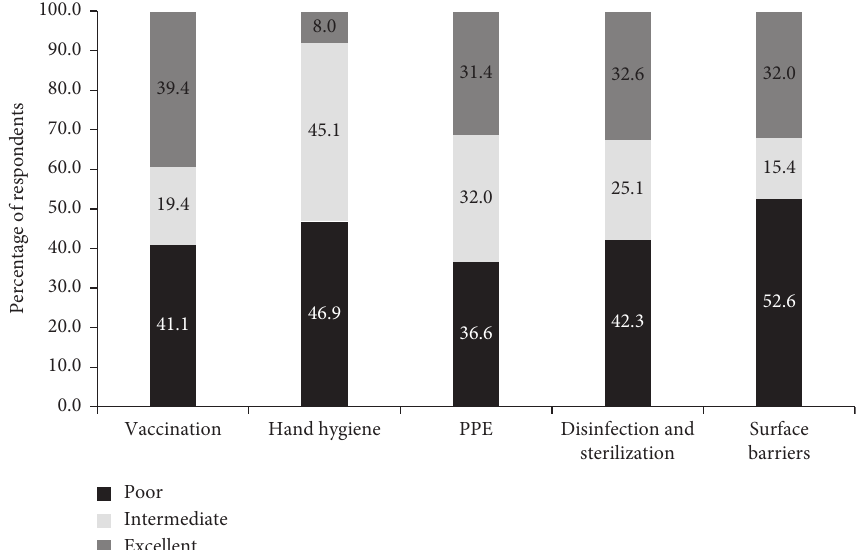
Figure 1: The level of compliance with infection control measures for all participants ( N � 175).